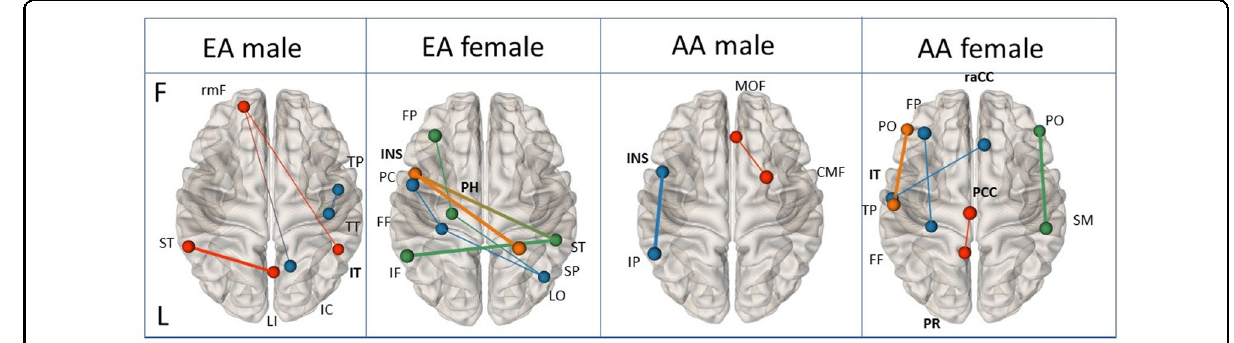
Fig. 2 EEG functional connectivity AUD remission biomarkers. AUD remission prediction models reveal ancestry/sex group-speci fi c brain connectivity biomarkers discriminating between those who recovered from AUD to those who did not. Results highlight lower connectivity in theta (blue) and gamma (red) in areas related to DMN (in bold -IT, PCC, PR, raCC, PH) and higher connectivity in theta (blue) and beta (orange) between insula and inferior and superior parietal regions respectively (in bold INS, IP, IT) speci fi c to every sex and ancestry predicting the maintenance of AUD. blue-theta, green-alpha, orange-beta, red-gamma. Thinner lines — lower connectivity, Thicker lines — higher connectivity. CMF Caudal middle frontal, FF fusiform, FP frontal pole, INS insula, IC Isthmus cingulate, IP inferior parietal, IT inferior temporal, LI lingual, LO Lateral Occipital, MOF medial orbito frontal, PC paracentral, PCC posterior cingulate cortex, PH parahippocampus, PO parsorbitalis, PR precuneus, raCC rostral anterior cingulate cortex, SM supramarginal, rmF Rostral middle frontal, TP temporal pole, TT Transverse temporal, SP Superior parietal, ST Superior